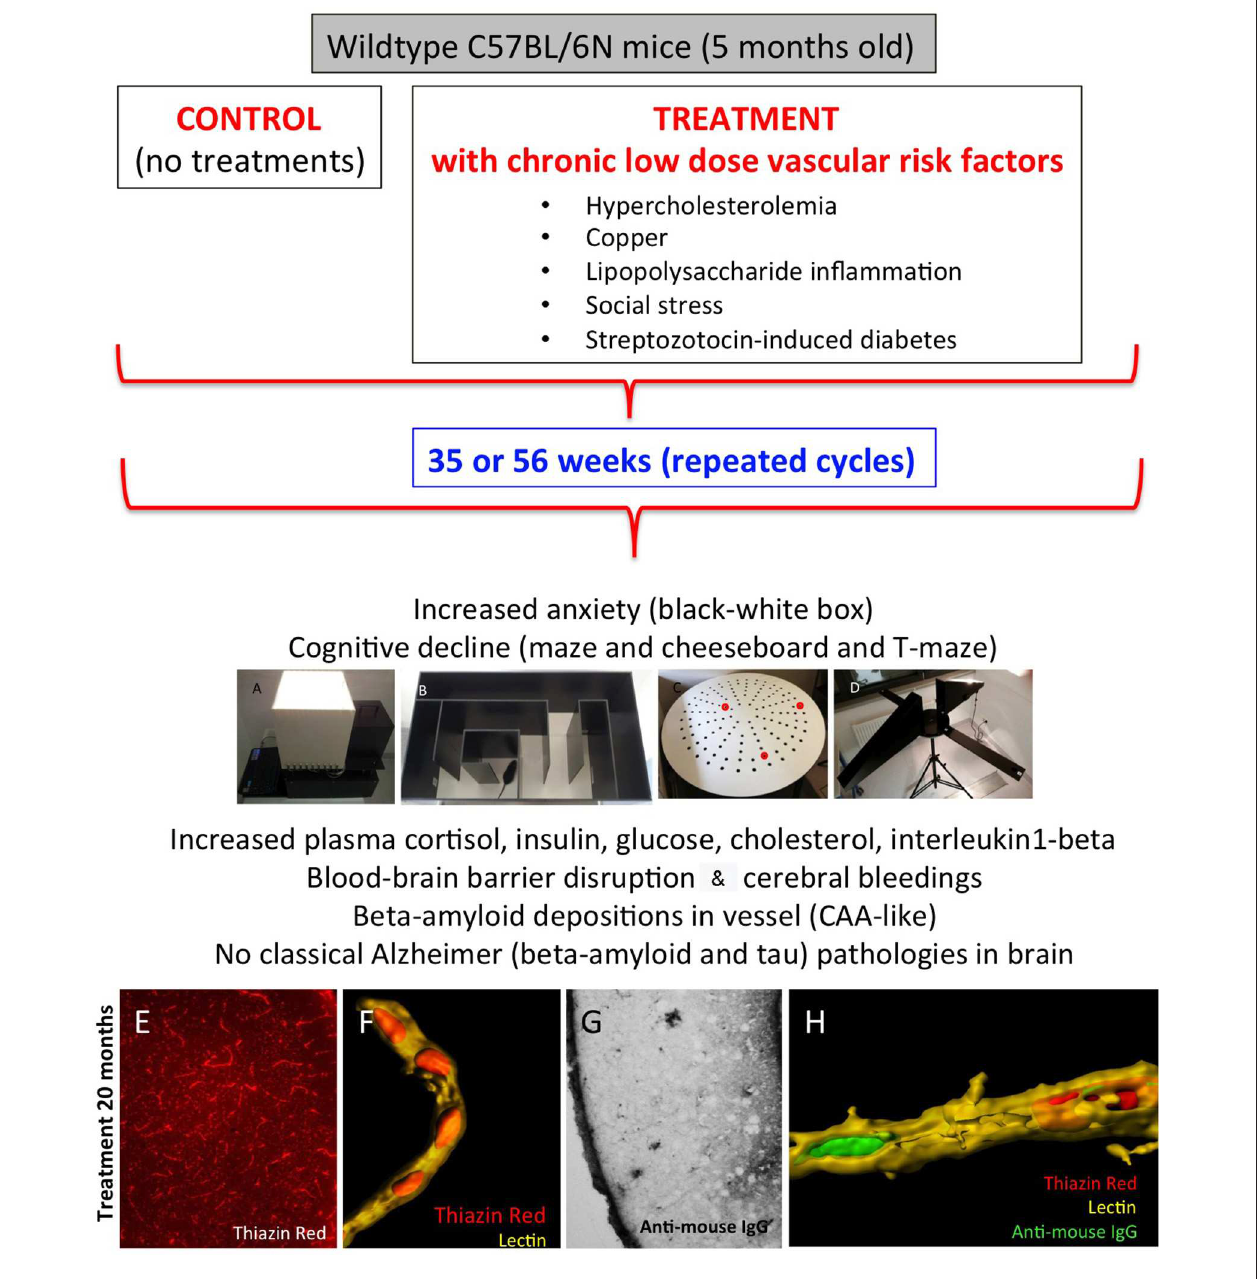
FIGURE 1 | Characterization of the novel sporadic mouse model of cerebral amyloid angiopathy (CAA). Healthy 5-month-old C57BL/6N mice were treated for 35 or 56 weeks with different low-dose vascular risk factors (treatments) or without (controls). The behavior was tested all 6 weeks using a black–white box (A) , labyrinth maze (B) , cheeseboard maze (C) , and at the end of the experiment with a T-maze (D) . Mice were analyzed for plasma levels and brain vessels and AD-like pathologies. Note that these mice exhibit a severe pathology for CAA, as seen by thiazine red staining (E) in lectin + vessels (F) and blood–brain barrier disruptions as seen by anti–mouse IgG staining (G) . (H) a representative confocal microscopy staining of a lectin + vessel (yellow) with thiazine red inclusions (red) and anti–mouse IgG (green). For methodological details and details on the model, refer to our original publication